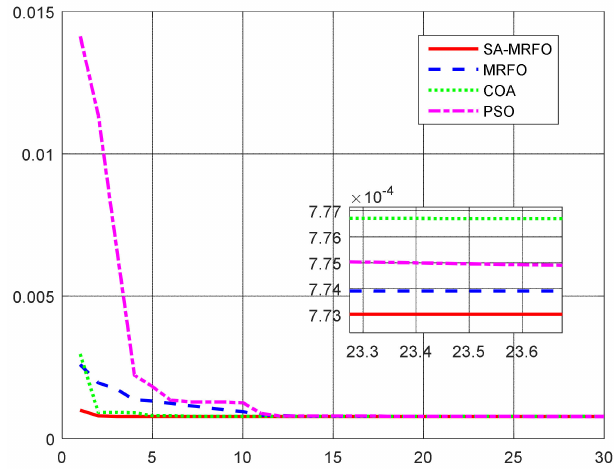
Figure 24. Comparison of the convergence curves for different optimization algorithms.